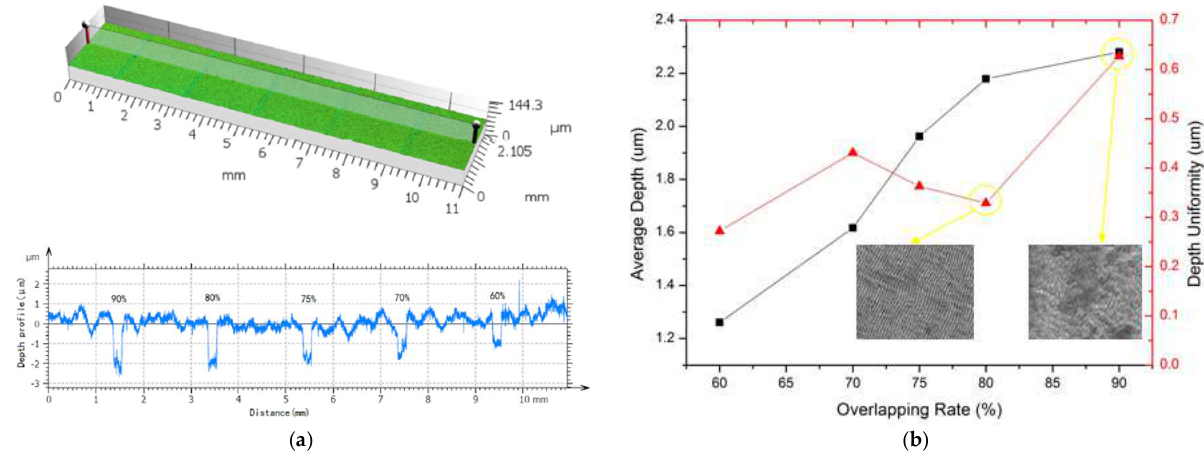
Figure 2. ( a ) Confocal data of depth profiles of the microgroove with different overlapping rates (from 90% to 60%). ( b ) Depth uniformity of the microgroove under different overlapping rates (from 90% to 60%).